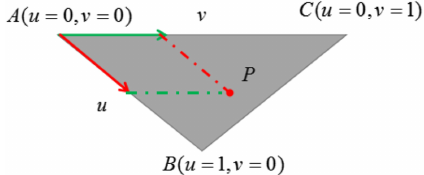
Figure 9. Area coordinate